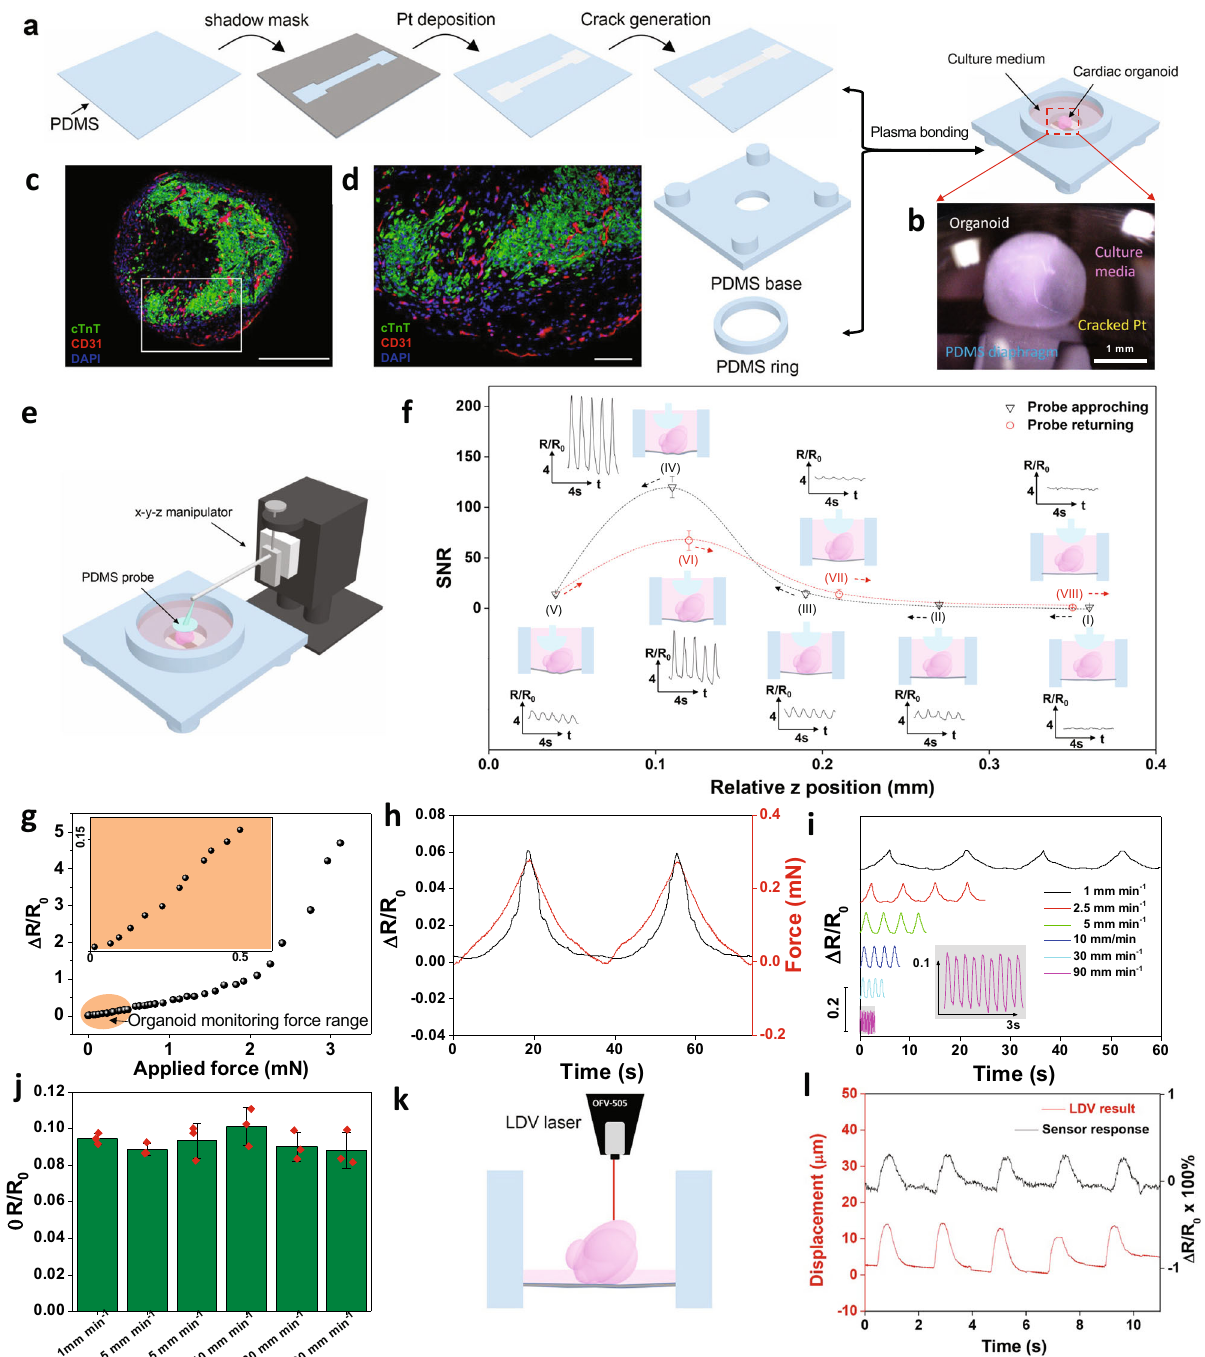
Fig. 1 | Fabrication and characterization of the elastic nanocracked force- sensingdiaphragm.a Schematicof thefabricationprocessofthePt-based elastic nanocracked force-sensing diaphragm assembled in a PDMS-based organoid cul- turechamber. b opticalimageofanorganoidandthesoftforcesensingdiaphragm interface. c , d Representativecross-sectionalimagesofanengineeredvascularized humancardiacorganoidstainedwith cardiactroponin T (green, cardiomyocytes), CD31 (red, endothelial cells) and DAPI (blue, nuclei) from three independent experiments with similar results. Scale bar in b and c are 500 μ m and 100 μ m, respectively. e Schematic of the experiment set-up of instantaneous organoid beating monitoring by the Pt-based force-sensing diaphragm with soft PDMS probe and x – y – z manipulator. f ‘ AFM-like ’ engaging process to achieve high SNR when the probe was approaching the organoid (position (I – V)) and departing